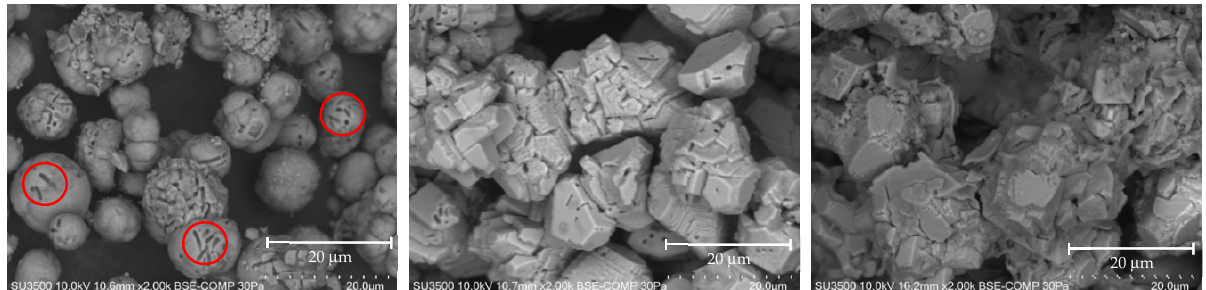
Figure 5. SEM images from solids recovered during CaCO 3 precipitation assays applying S. pasteurii . Day 1 ( Left ), day 3 ( Middle ) and day 5 ( Right ). Red circles in Figure ( Left ) show bacillus shapes indicating the presence of S. pasteurii in the precipitate.